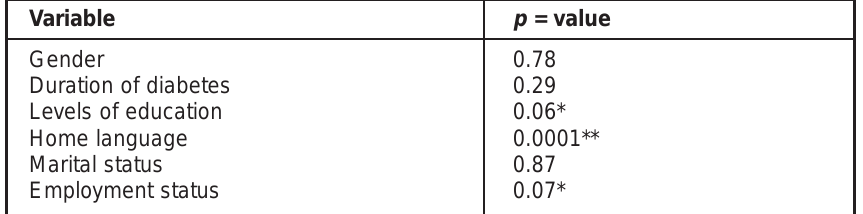
Table 4: Correlation between the scores for the self-efficacy categories and demographic variables using the chi-square test